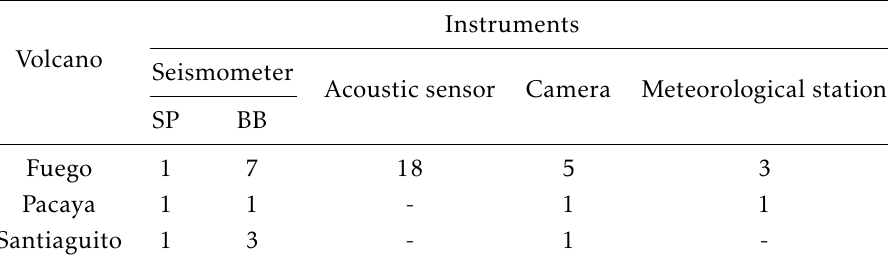
Table 2: Description of the volcano monitoring networks